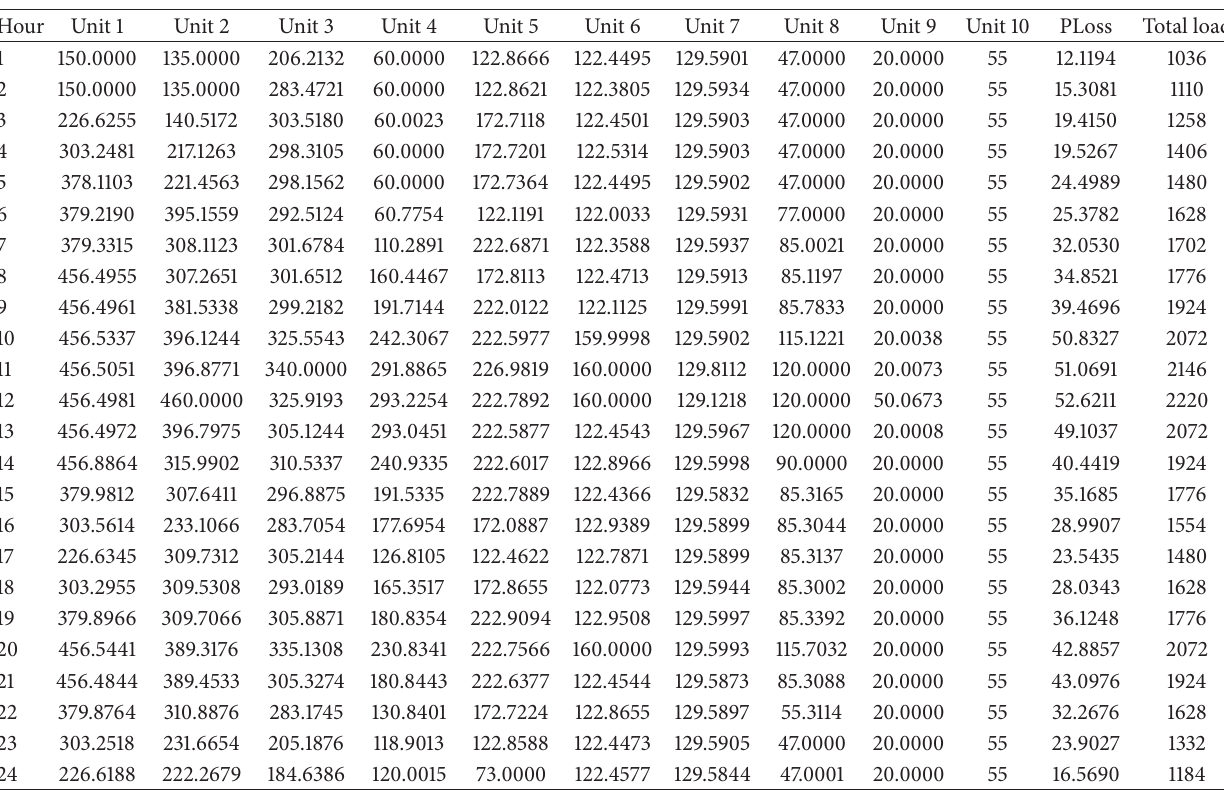
Table 5: Best solutions obtained by the proposed IDEBDSS method for test system 2